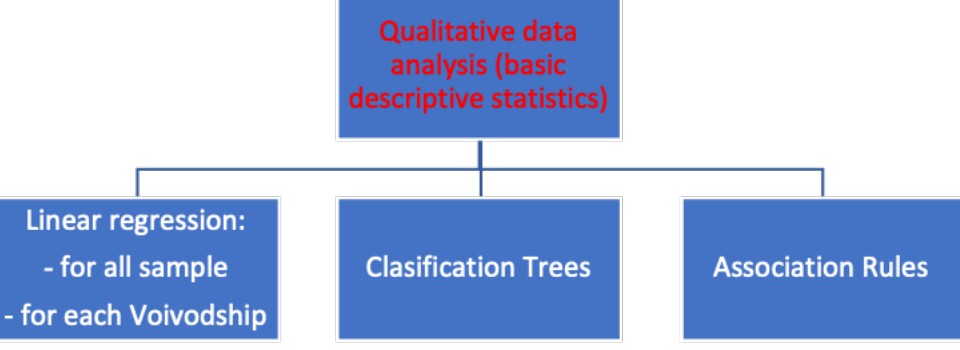
Figure 1. Methods used in the empirical study.